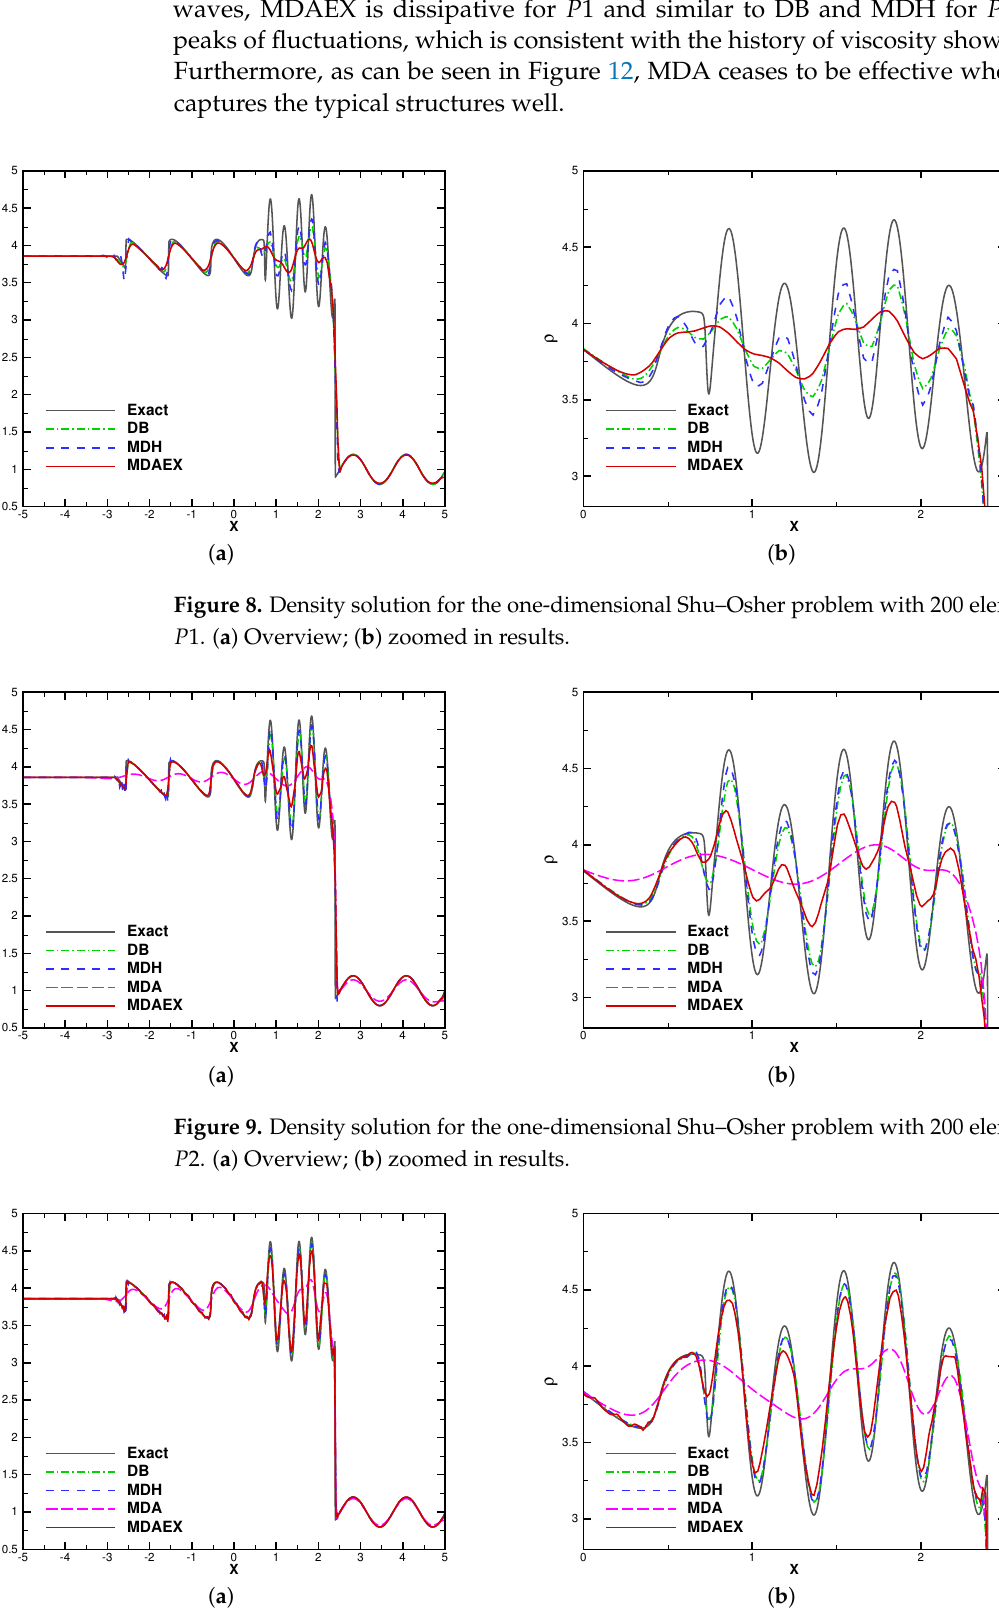
Figure 10. Density solution for the one-dimensional Shu–Osher problem with 200 elements at t = 1.8, P 3. ( a ) Overview; ( b ) zoomed in